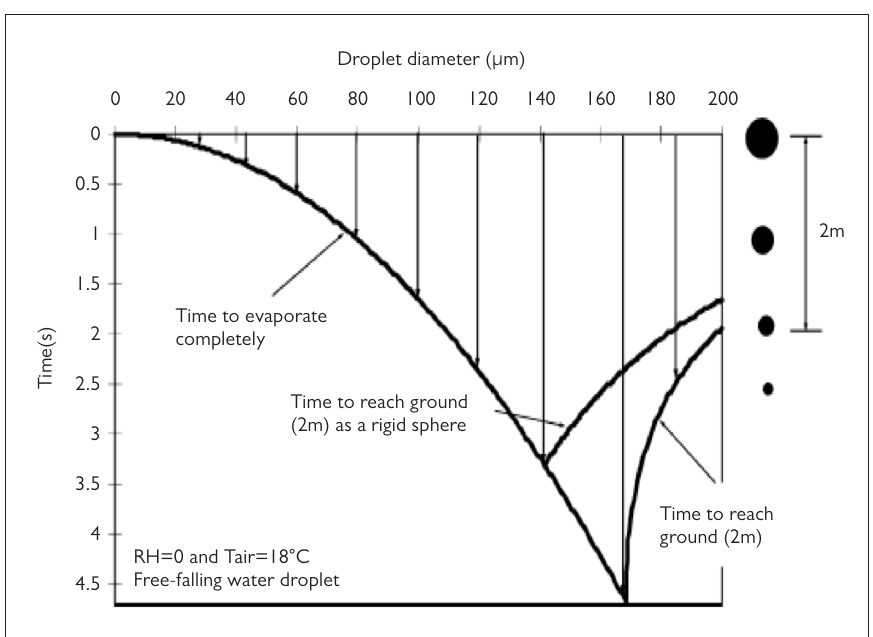
Figure 1. a-d. Images of the thoracic CT scans of patients in a family and the multifocal ground- glass changes in the lungs of mother (a), father (b), daughter (c), and grandson (d) [Reprinted with permission from [14]